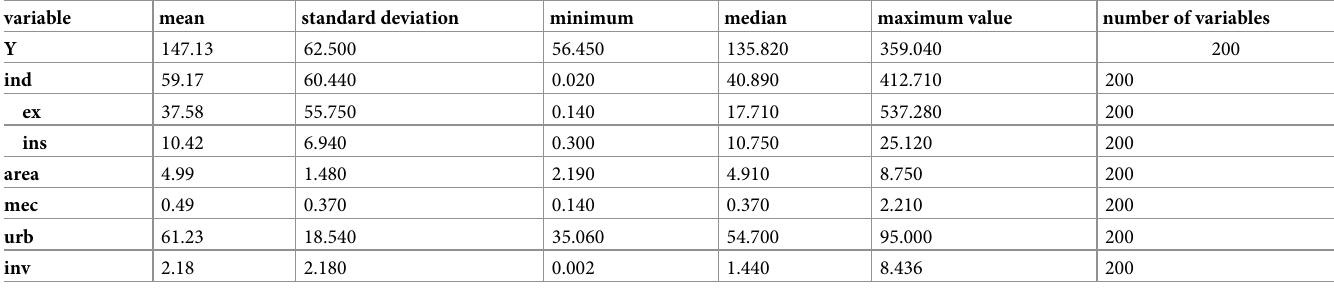
Table 3. Descriptive statistics for each